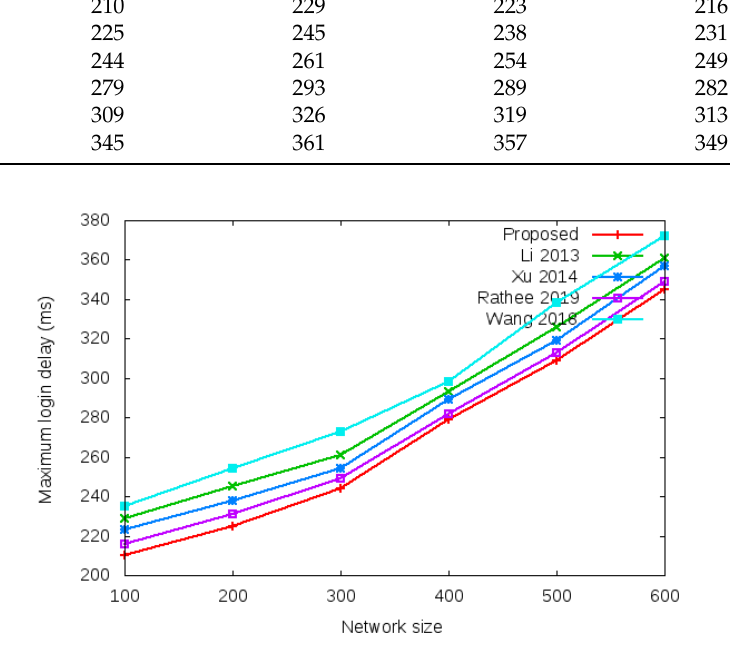
Figure 13. Maximum login authentication